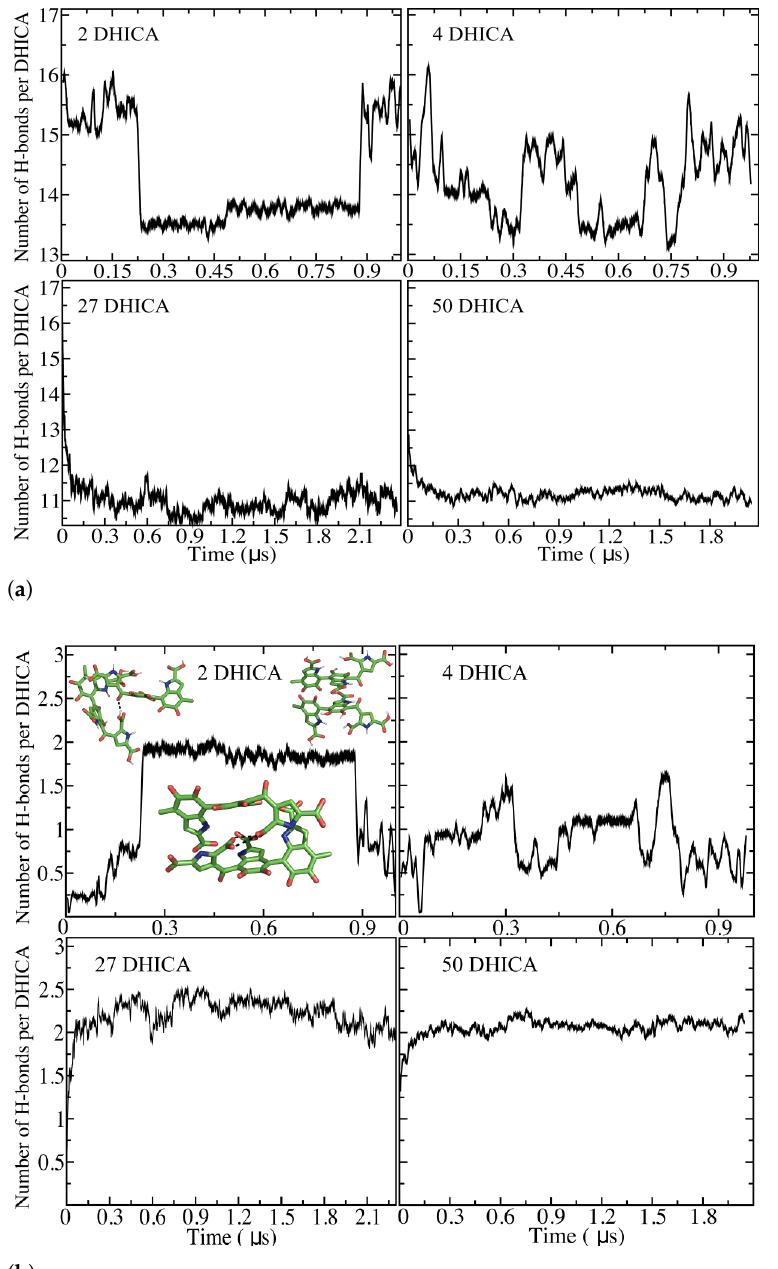
Figure 10. Time evolution of the number of hydrogen bonds per monomer for two, four, 27, and fifty DHICA-eumelanin systems ( a ) between DHICA eumelanin and water and ( b ) between the eumelanin